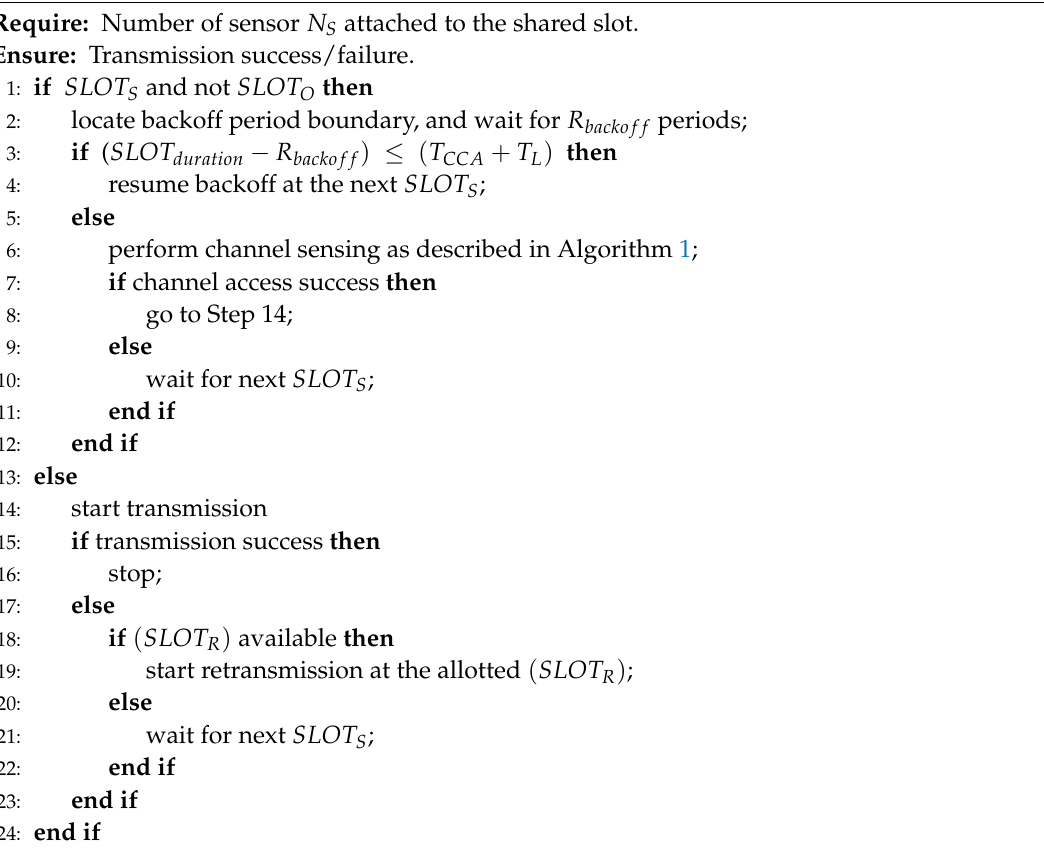
Algorithm 2 New channel access